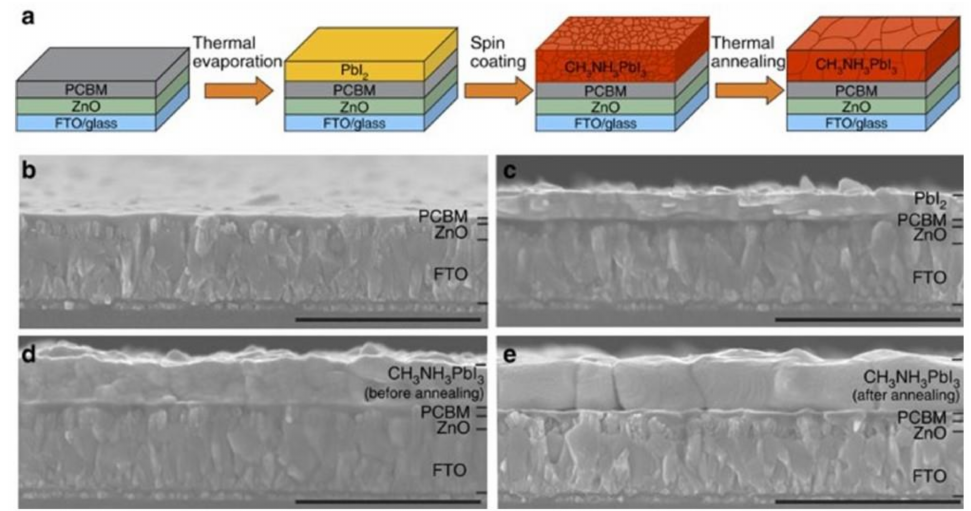
Figure 4. ( a ) Preparation steps of perovskite-based device; ( b – e ) the cross-sectional SEM images of the sample for each preparation step. (Figure reprinted from Fu et al. [33], copyright (2023) with permission of Nature